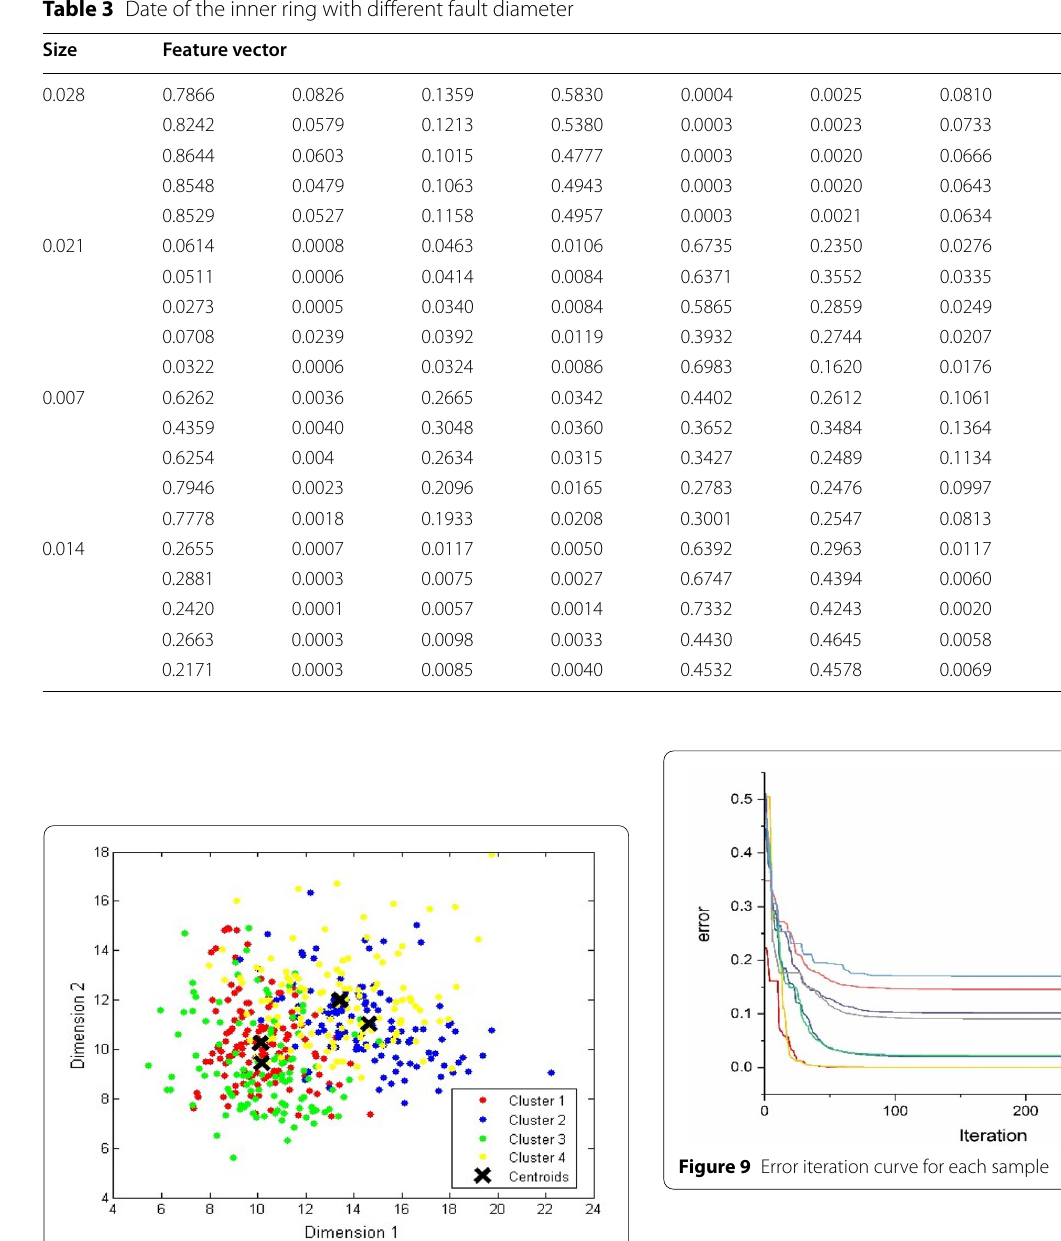
Figure 8 Visualization of the feature